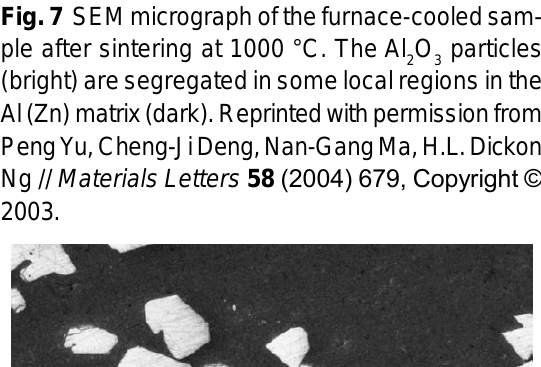
O particles 2 3